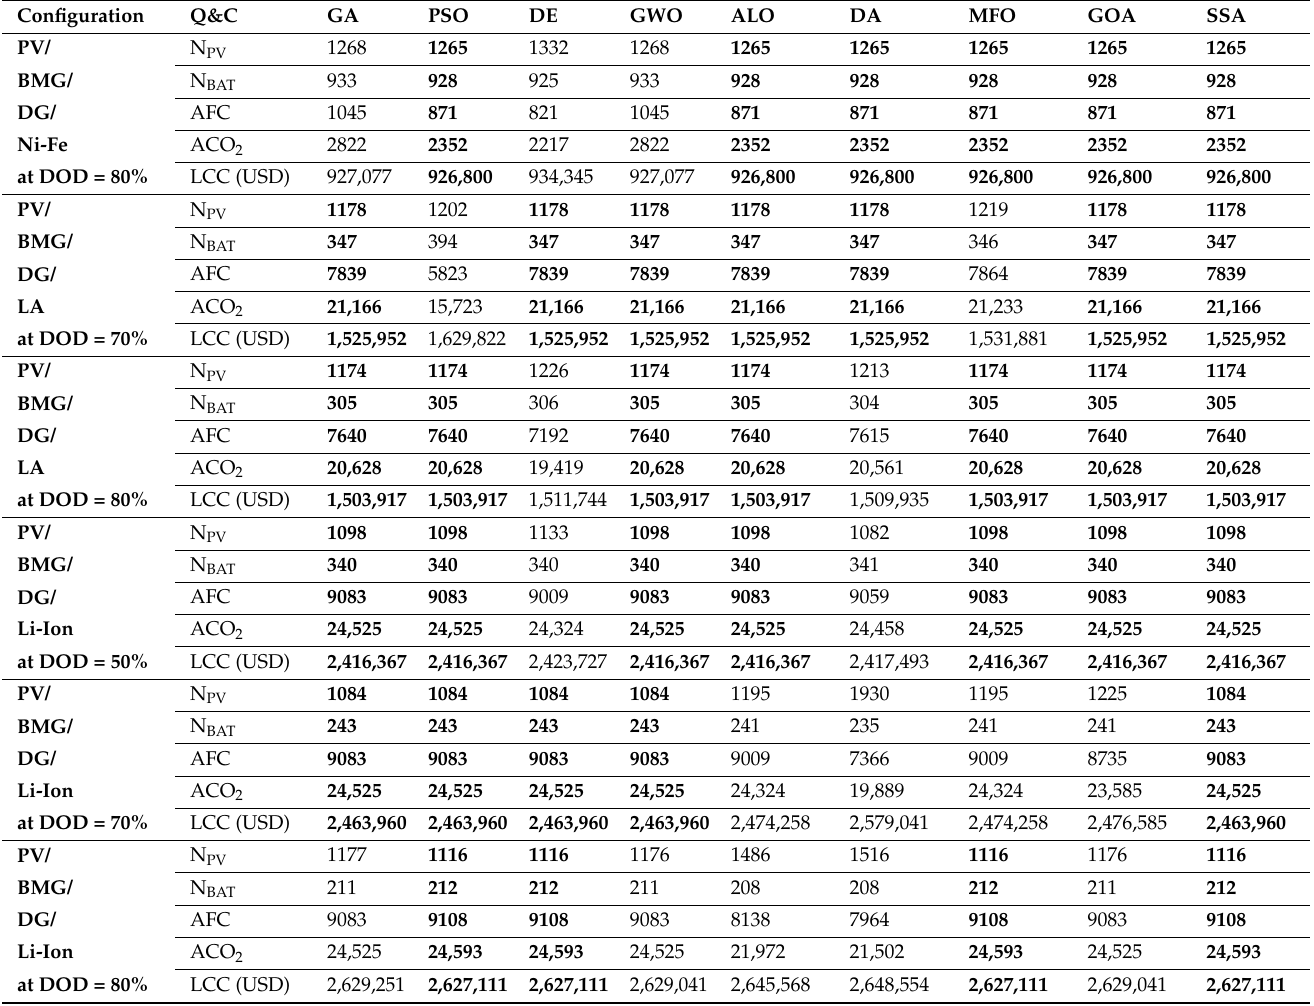
Table 9. Optimization results of the HPRALC-based IHRES using CC strategy at LPSP value of 0%.